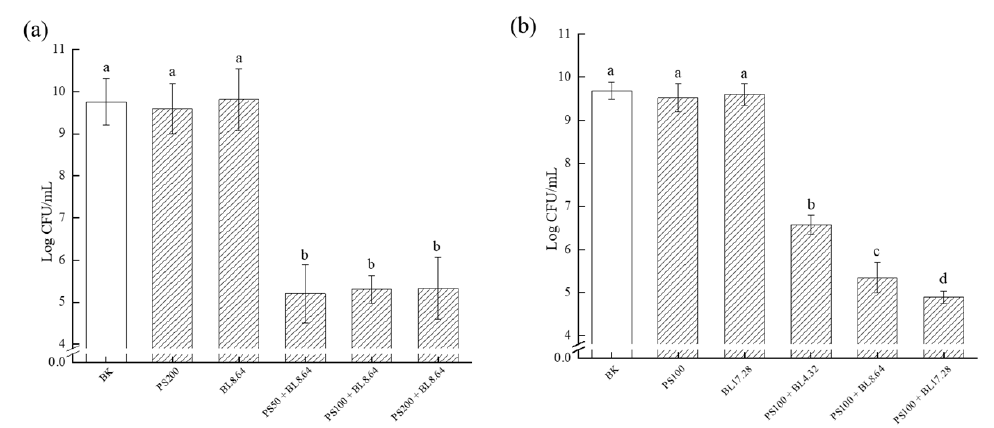
Figure 2. Viable bacterial counts of S. saprophyticus biofilm after PDI treatment under different curcumin concentration ( a ) and light dose ( b ). BK: blank control; PS: photosensitizer treatment; BL: blue-light treatment; PS + BL: photosensitizer combined blue-light treatment. Values are presented as mean ± SD. Different letters indicate significant difference between the test samples ( p < 0.01).